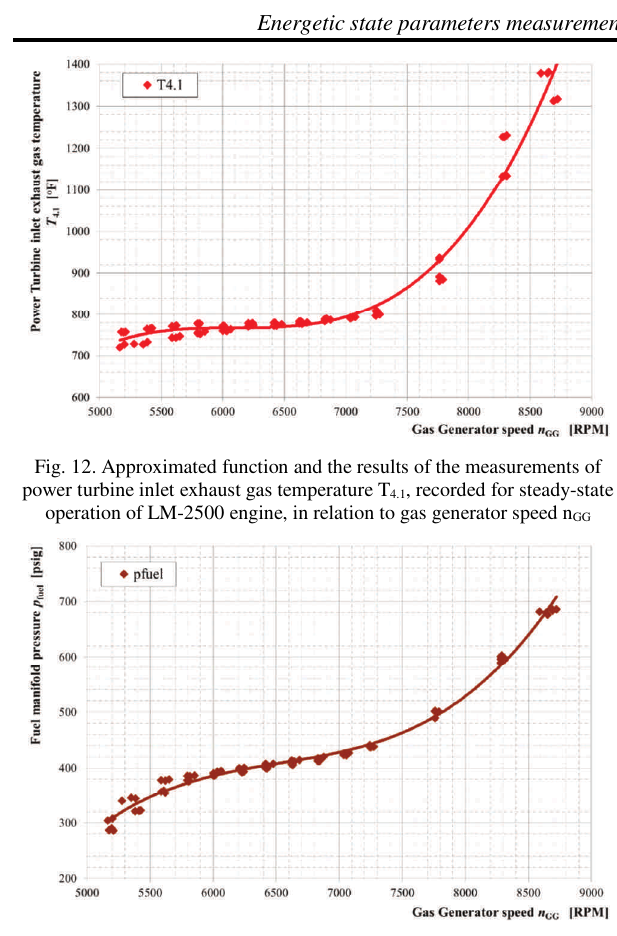
Fig. 13. Approximated function and the results of the measurements fuel Fig. 15. Approximated function and the results of the measurements of manifold pressure p fuel , recorded for steady-state operation of LM-2500 power output P, recorded for steady-state operation of LM-2500 engine, in engine, in relation to gas generator speed n GG relation to gas generator speed n GG Table 3. The results of statistical analysis of approximated operating